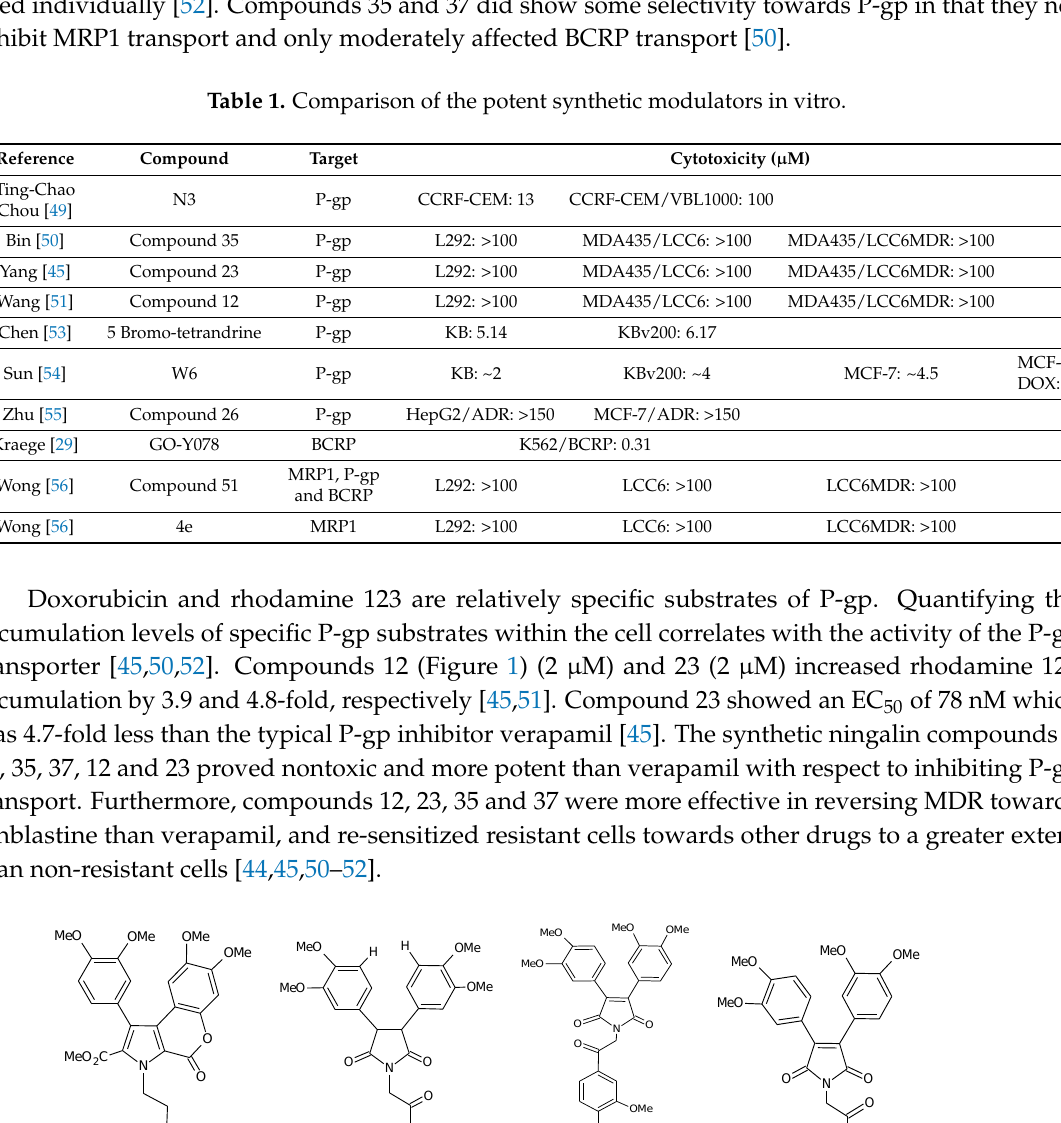
Table 1. Comparison of the potent synthetic modulators in vitro.